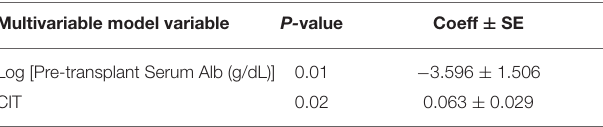
TABLE 3 | Selected logistic model (obtained via stepwise regression) for the likelihood of receiving a drain (35 events) and propensity score. Multivariable model variable P-